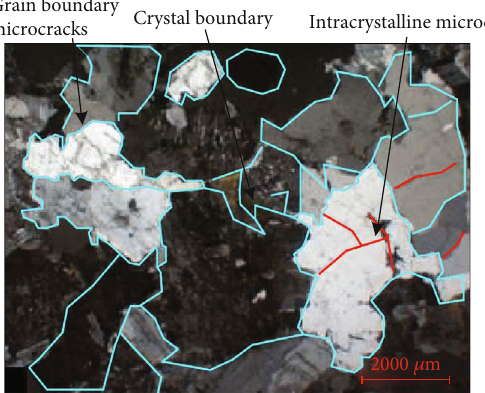
Figure 1: Micrograph of